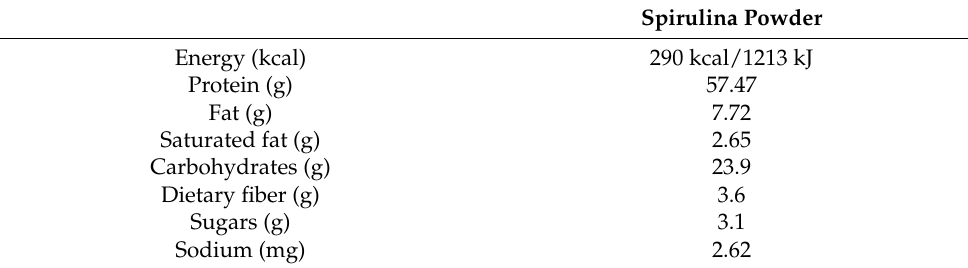
Table 3. Nutrient composition of spirulina powder per 100 g based on the food